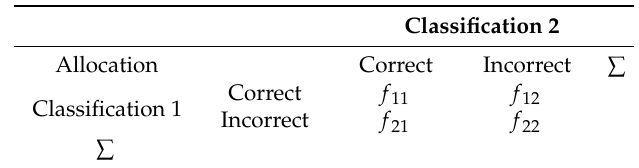
Table 6. Assessment of the statistical significance between two classifications using McNemar’s test.